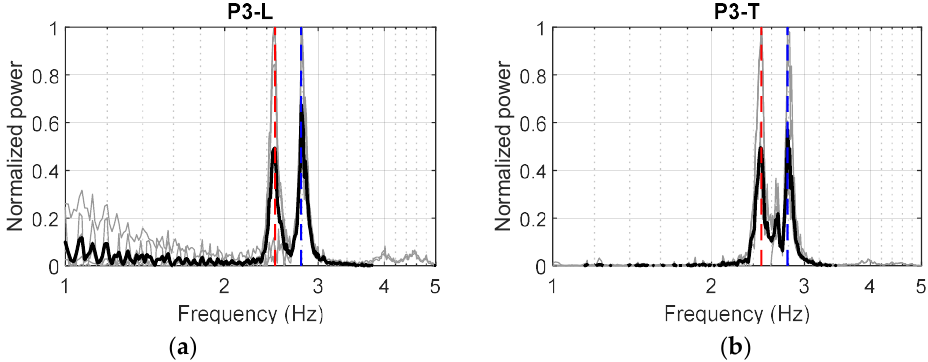
Figure 14. The cross power spectral densities (CPSD) (grey lines) of the combination between the longitudinal ( a ) and transversal ( b ) signals in point P3 and the rest of the signals in the same directions. The black lines correspond to the mean CPSD and the frequencies 2.49 and 2.79 Hz are indicated with red and blue dashed lines,